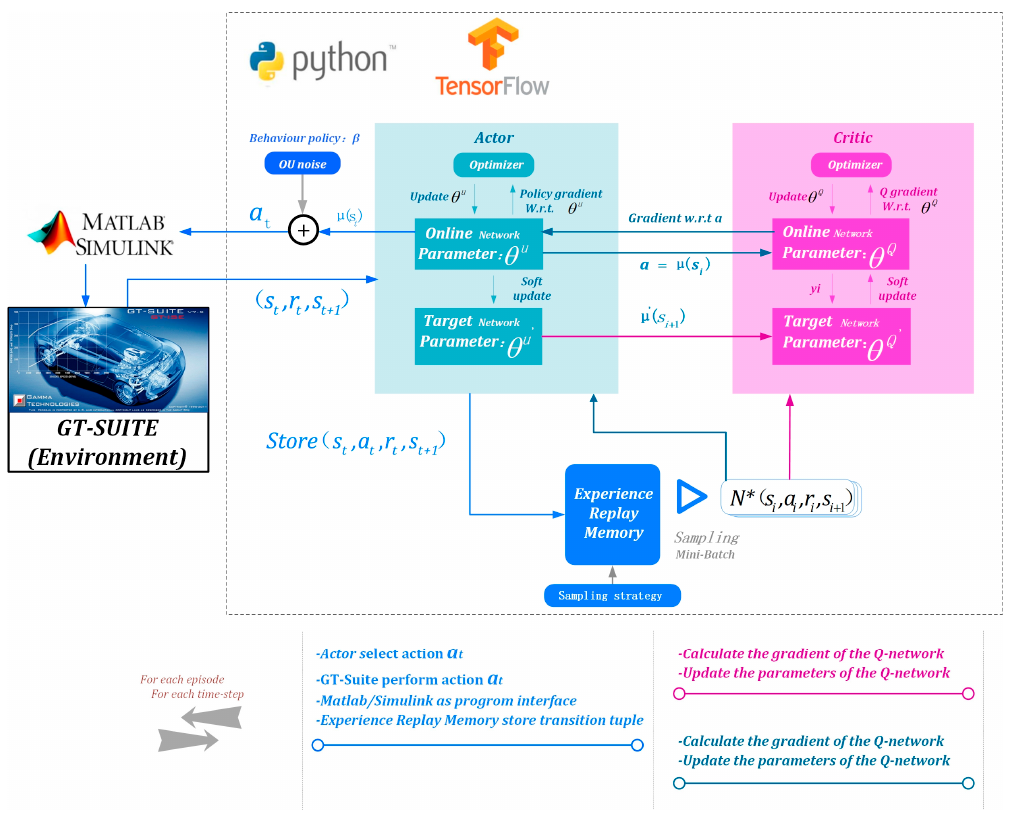
Figure 10. Deep deterministic policy gradient (DDPG) algorithm implementation and the corresponding co-simulation platform.